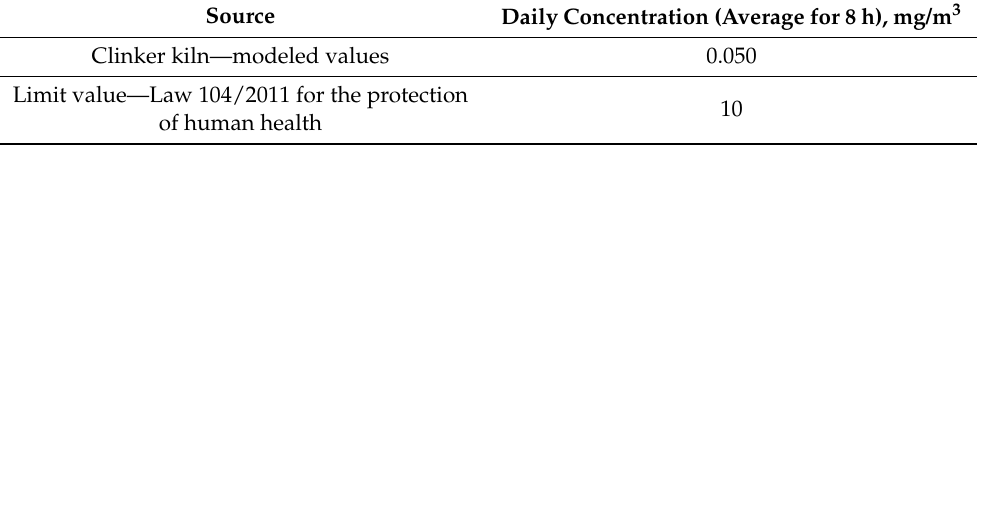
Figure 17. Annual CO concentration in the area of interest — Google Earth Pro . It is observed that the maximum value of the modeled CO concentration complies with the limit value provided in Law 104/2011, according to Table 10. For SO 2 , the maximum modeled concentrations (hourly and daily) are shown in Ta- ble 11 and Figures 18 and 19.